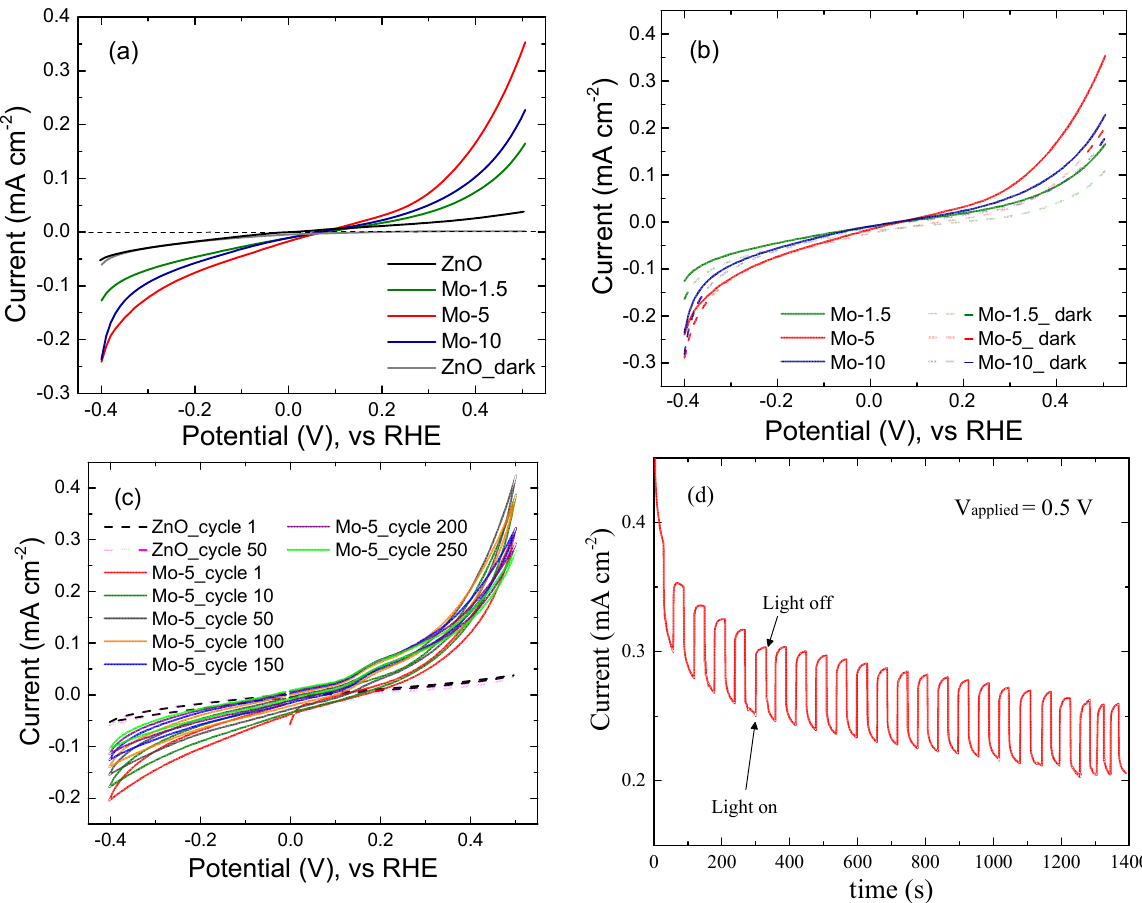
Figure 6. ( a , b ) LSV curves both in the dark and under illumination of bare ZnO and ZnO/MoS 2 heterostructures with different nominal Mo thicknesses (scan rate 50 mV s −1 ). ( c ) Cyclic voltammetry curves of bare ZnO NWs and ZnO/MoS 2 heterostructures for the Mo-5 sample. ( d ) Chronoamperometric curve (J vs. t) for the Mo-5 sample at the applied potential of 0.5 V vs. RHE under chopped illumination.